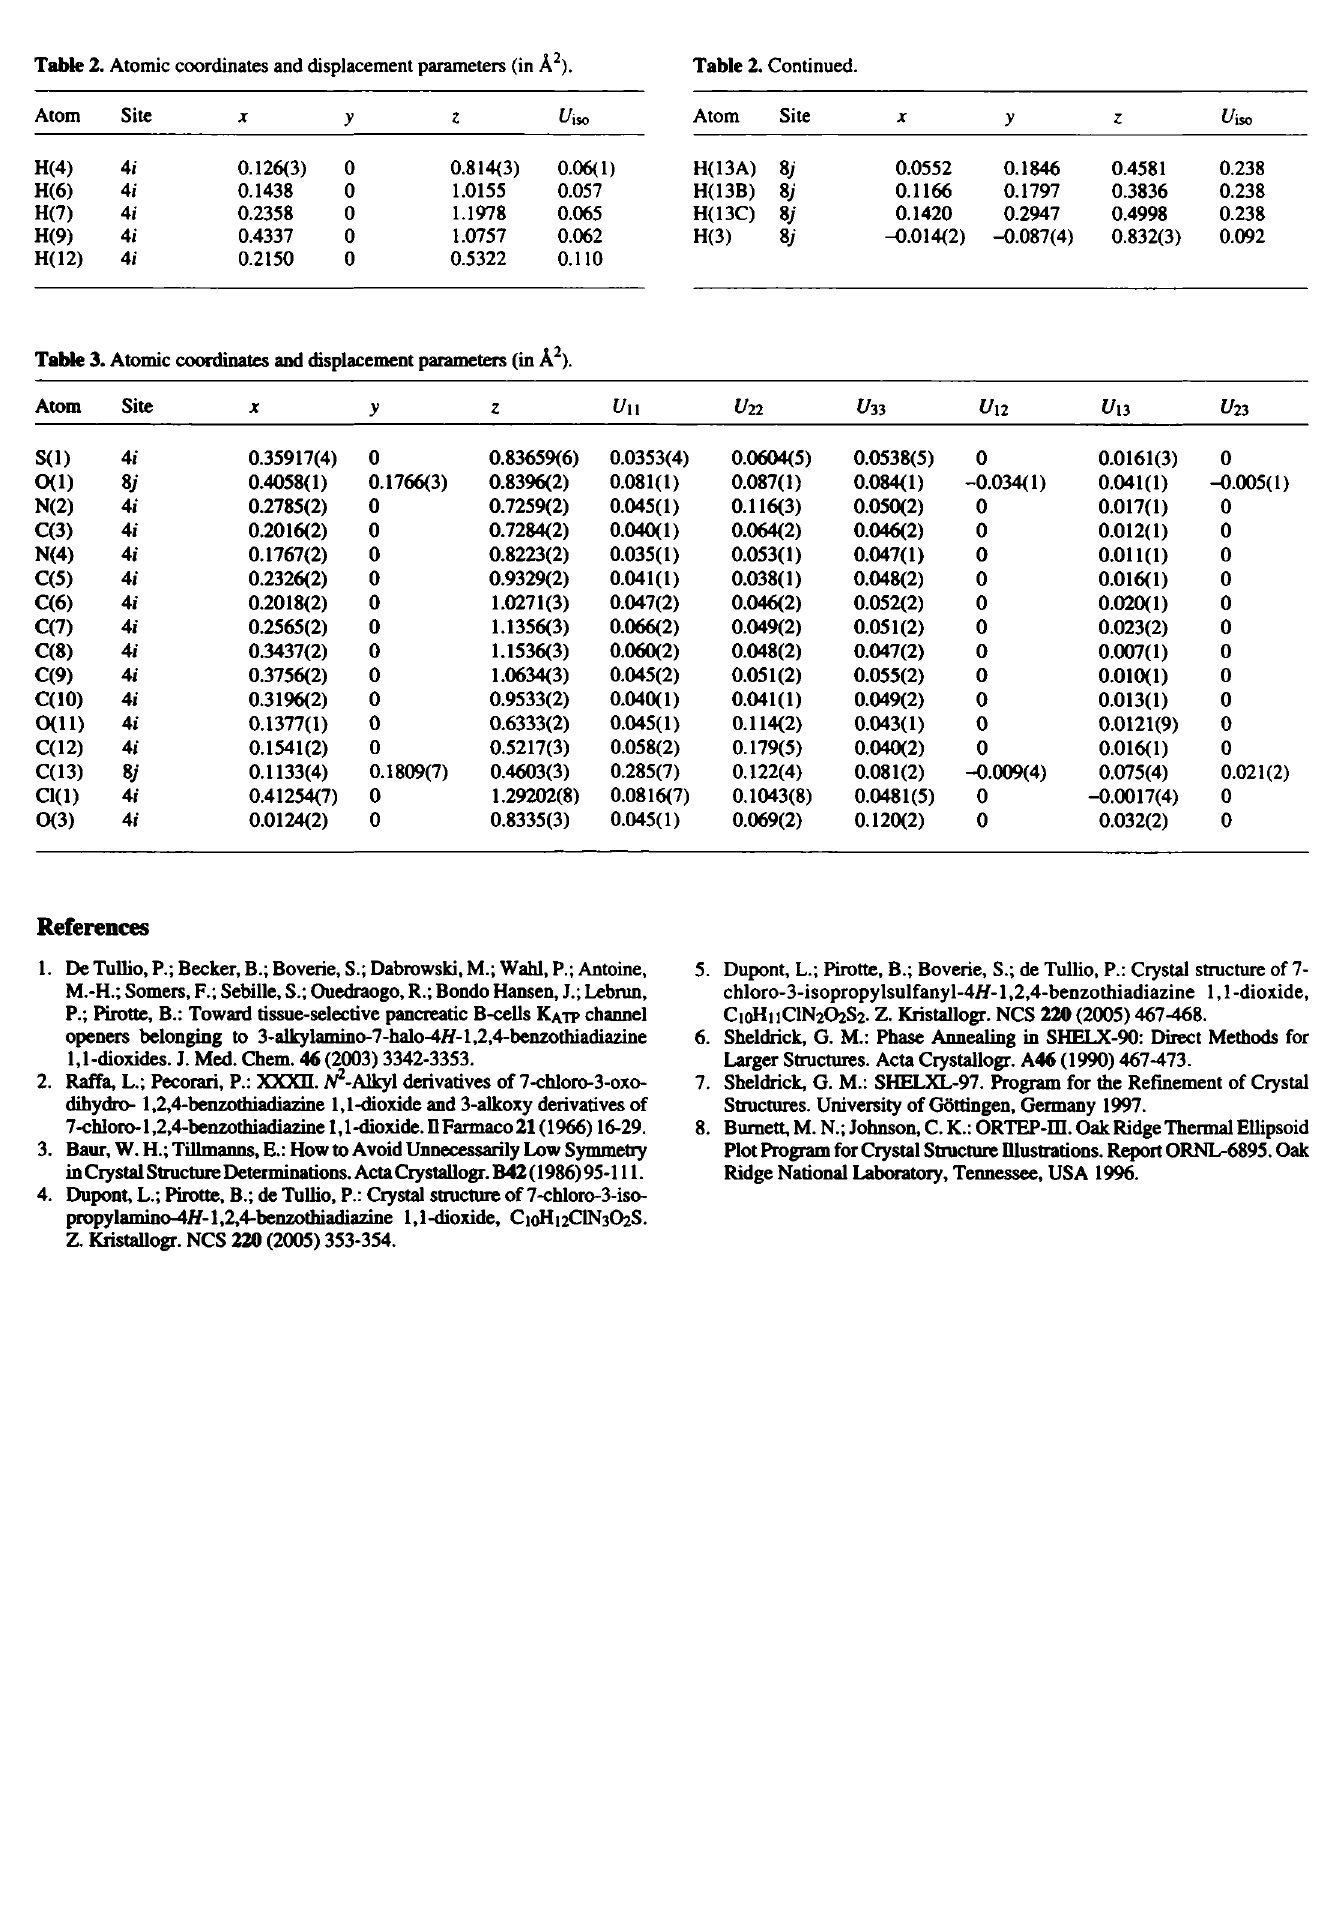
Table 2. Atomic coordinates and displacement parameters (in A 2 ).